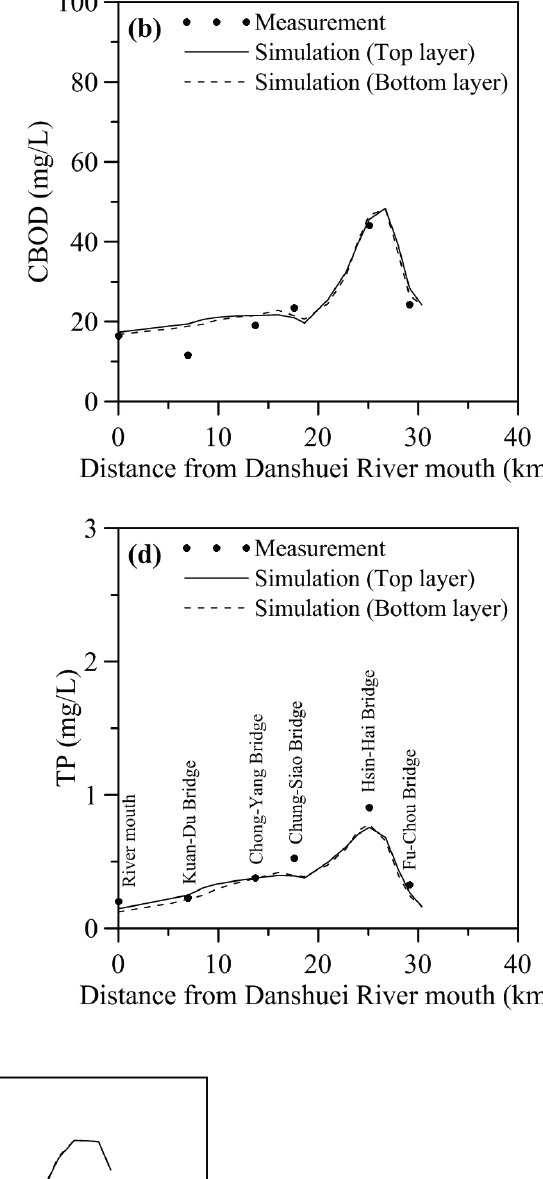
Figure 5. Comparison between measured and simulated water quality distribution along the Danshuei River to Tahan Stream on 1 March 2010: ( a ) dissolved oxygen (DO); ( b ) carbonaceous biochemical oxygen demand (CBOD); ( c ) NH (TP); and ( e ) NO (simulated result shown only as no NO 3